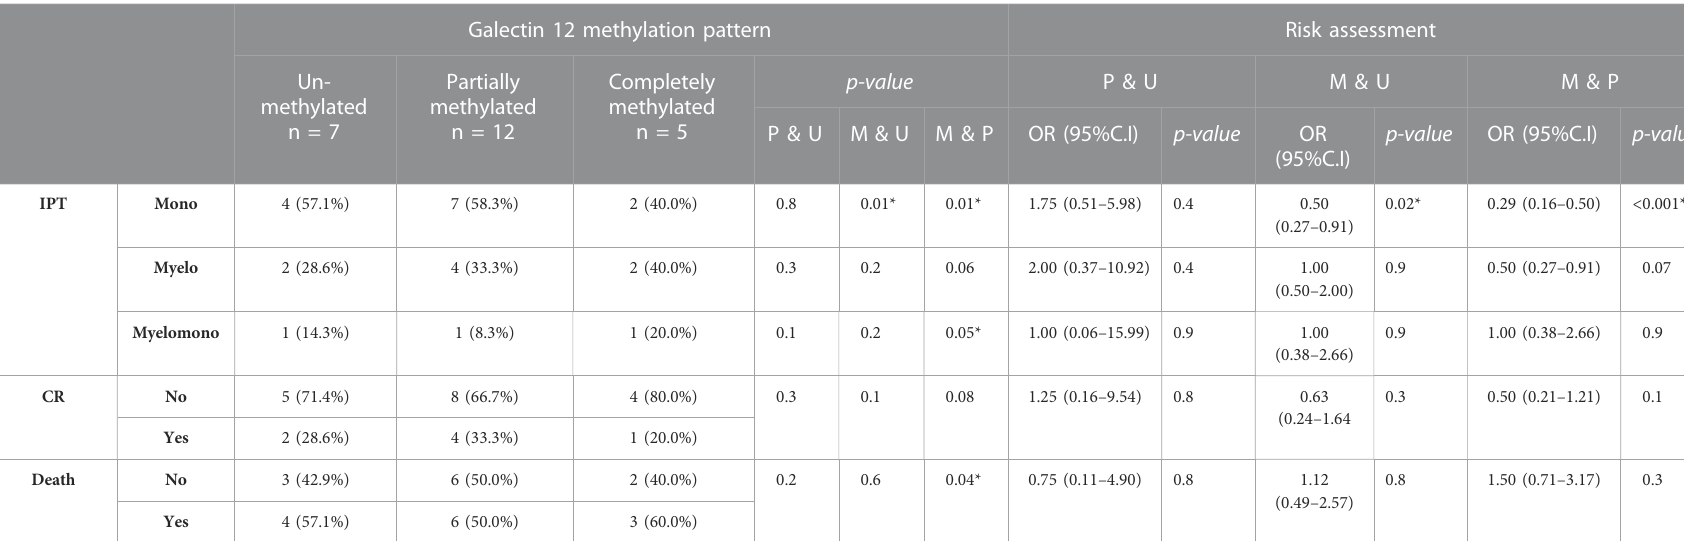
TABLE 5 ( Continued ) Relation of the methylation pattern of galectin 12 and clinicolaboratory data of the studied